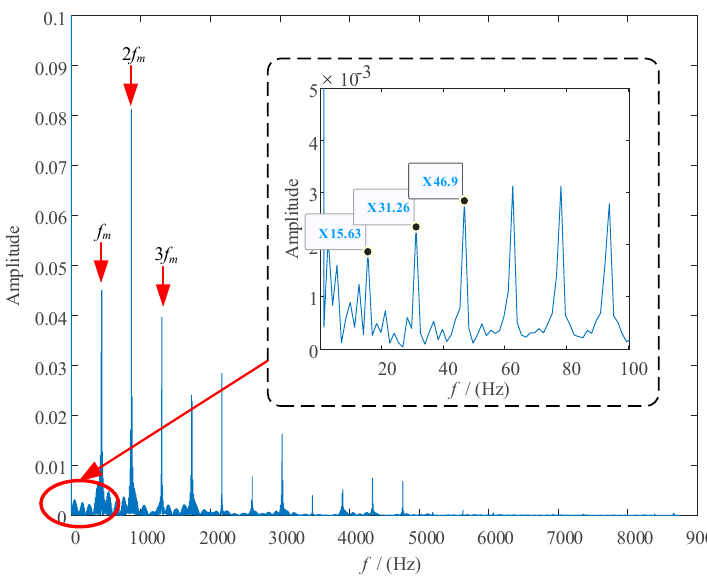
Appl. Sci. 2020 , 10 , x FOR PEER REVIEW Figure 15. Simulation signal spectrum in healthy condition. Figure 15. Simulation signal spectrum in healthy condition.